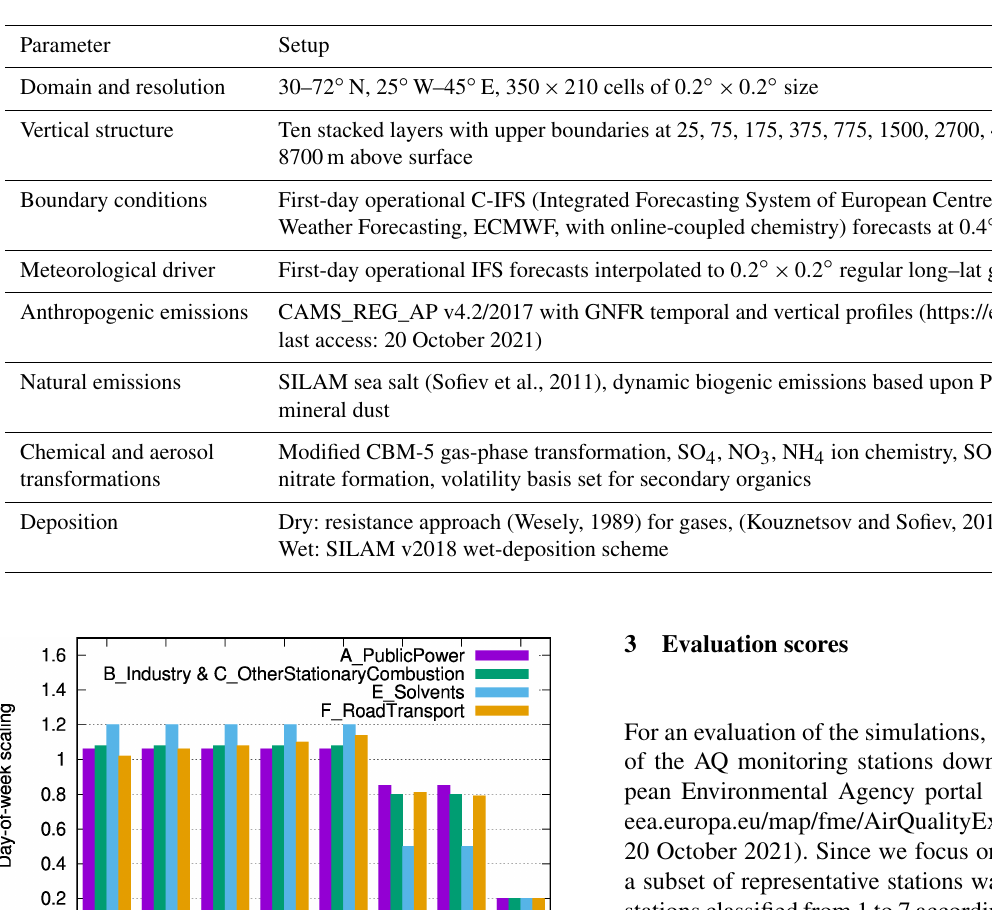
Table 4. SILAM setup.